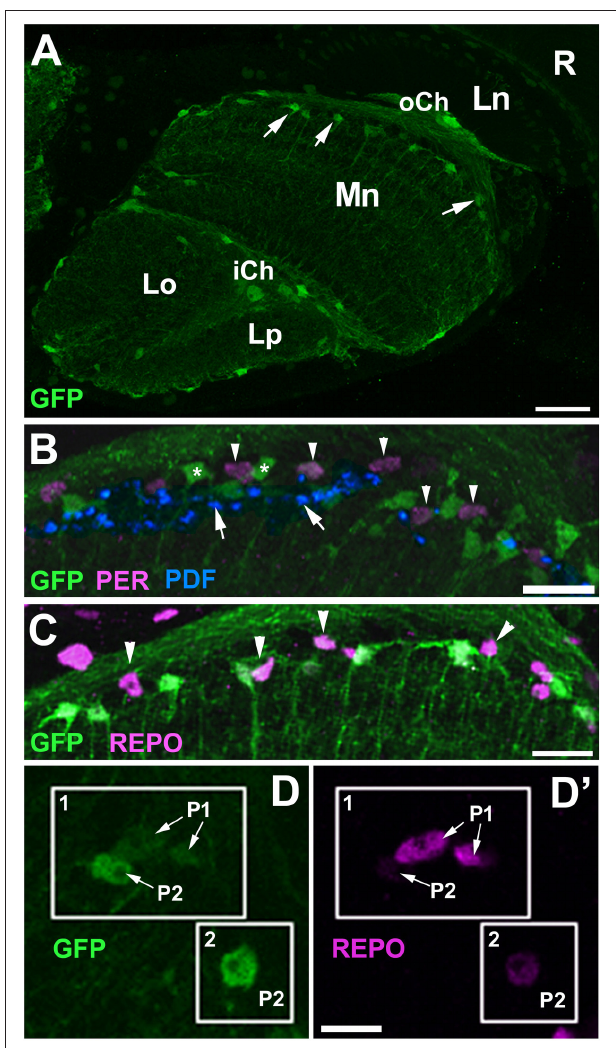
FIGURE 4 | Colocalization of PER and REPO to the astrocyte-like glia (ALGl) of alrm -Gal4/UAS-S65T-GFP flies collected at ZT1. (A) Localization of ALGl (arrows) in the distal part of the medulla neuropil (Mn) in horizontal section. R, retina; Ln, lamina neuropil; oCh, outer chiasm; iCh, inner chiasm; Lo, lobula; Lp, lobula plate. Scale bar: 20 µ m. (B) GFP-expressing ALGl (asterisks) in the region of PDF-positive terminals (arrows) of l-LNv neurons do not express PER. PER-positive nuclei (arrowheads) are located in between the cell bodies of ALGl. Scale bar: 10 µ m. (C) GFP-negative nuclei of non-ALGl (arrowheads) express REPO at high level. Scale bar: 10 µ m. ( D , D’ ) ALGl and non-ALGl cells of the distal medulla in higher magnification. ALGl cells (box 1 and 2) that express GFP at high level (D) , show weak expression of REPO (D’) , whereas non-ALGl cells (box 1) that express GFP at barely detectable level (D) , show strong REPO expression (D’) . Scale bar: 5 µ